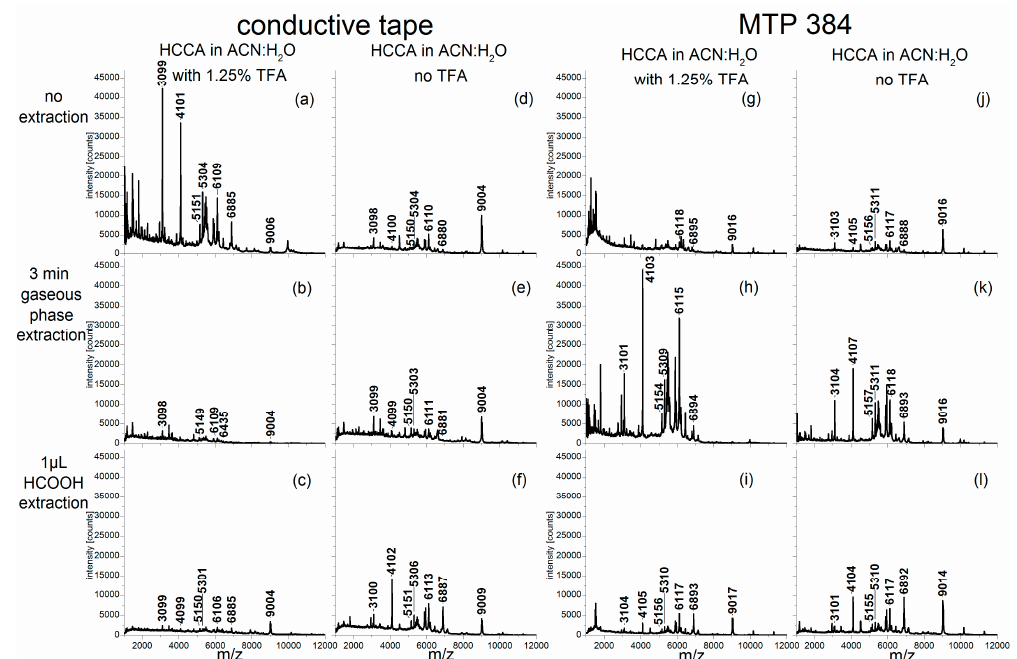
Figure A2. Averaged MALDI-TOF mass spectra ( n = 5) of Corylus avellana pollen grains: measured on conductive tape with TFA in the matrix solution ( a – c ), on conductive tape without TFA in the matrix solution ( d – f ), on the steel target (MTP 384) with TFA in the matrix solution ( g – i ) and on the steel target without TFA in the matrix solution ( j – l ) (in the rows: extraction procedure).